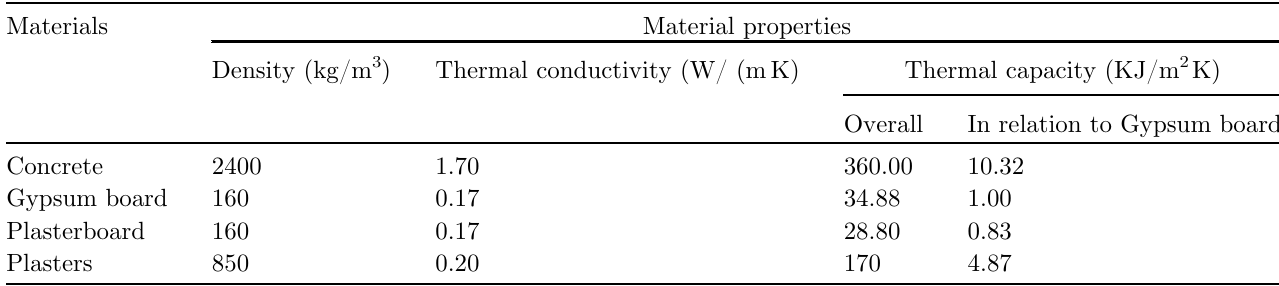
Table 2. Estimated energy storage properties of building materials of 20 cm